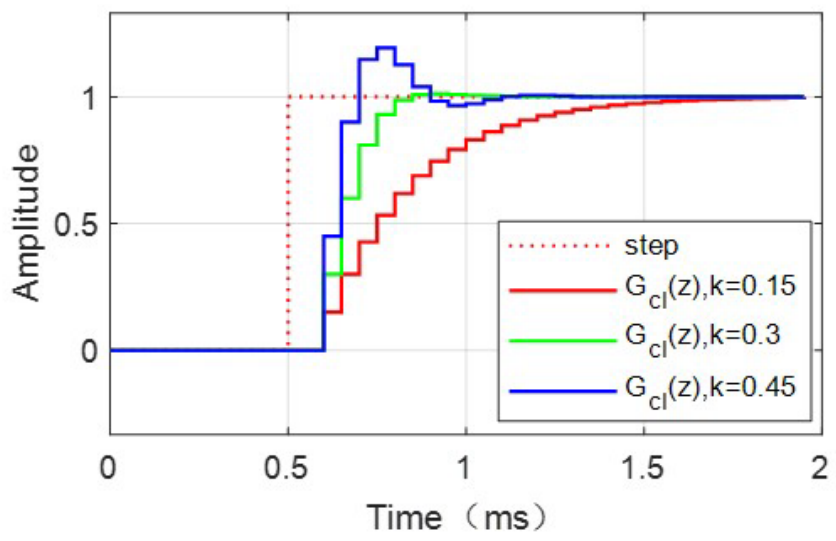
Figure 6. Step response of ideal closed-loop transfer function with different parameters.